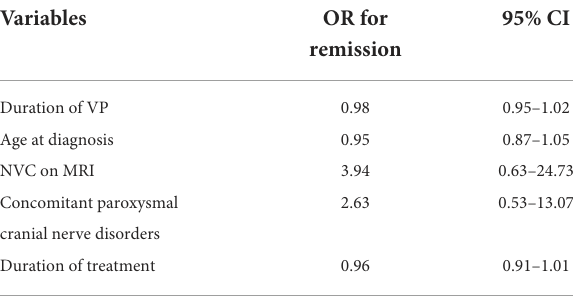
TABLE 4 Univariate logistic regression analysis for different variables for predicting